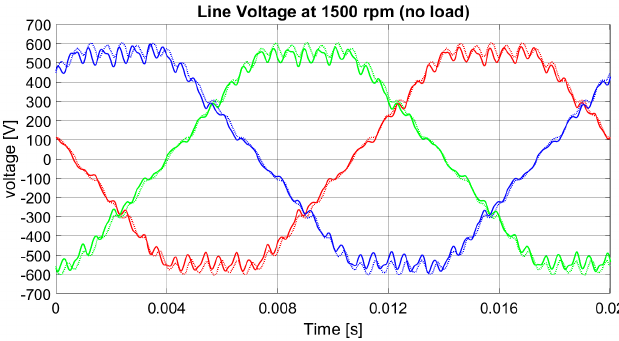
Figure 8. Back EMF of the healthy PMSG; dotted lines are FEA results.